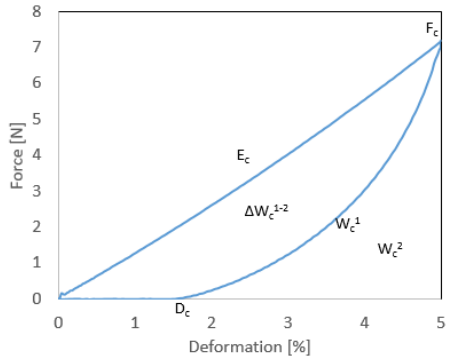
Figure 1. Force/deformation curve obtained from compression test and extracted parameters.